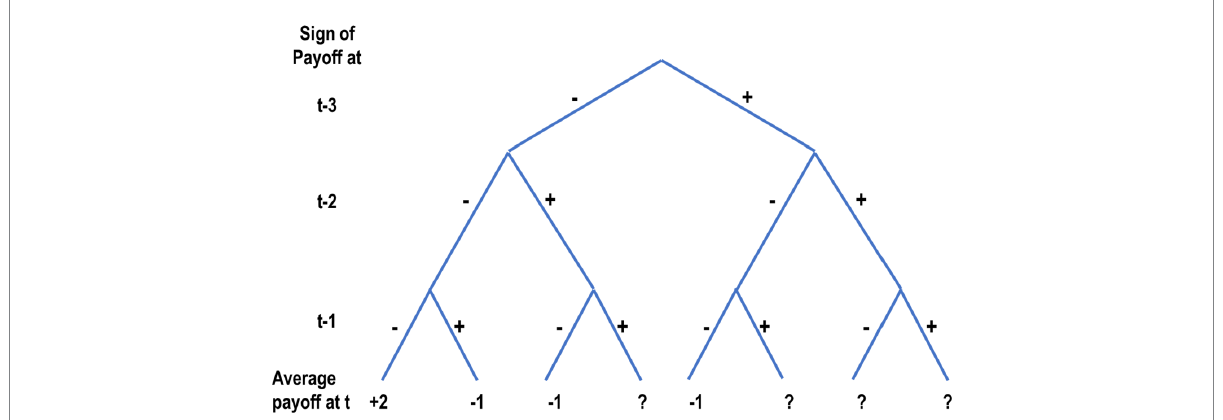
FIGURE 8 A decision tree analysis of the results in the first 15 trials of the thought experiment presented in Figure 6. The average payoff line presents the observed average payoff in each category. The question mark (?) implies that the training data do not include observation in the relevant